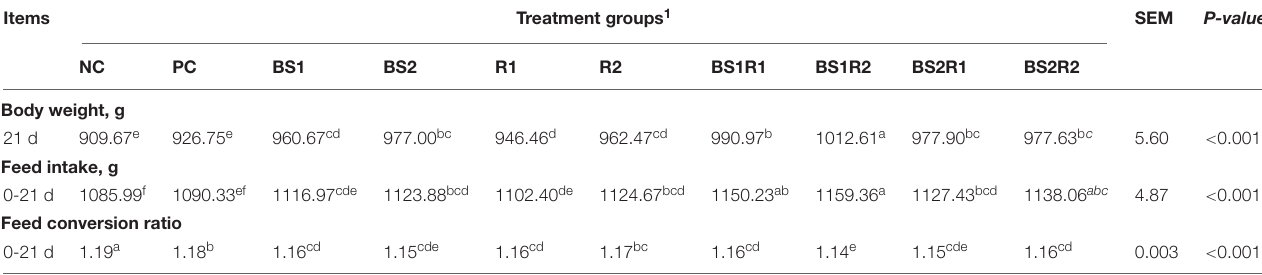
TABLE 3 | Effect of in ovo inclusion of Bacillus subtilis , raffinose, and their synbiotics on growth performance of 21-day-old